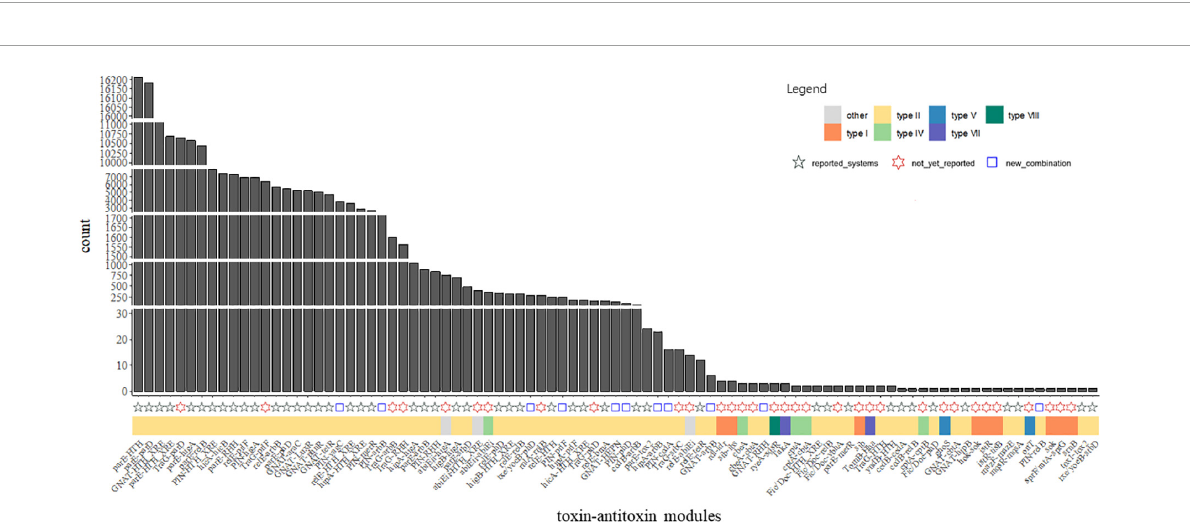
FIGURE4 Abundance of the TA modules among P. aeruginosa population. Count indicates the absolute counts of TA homologs of specific systems, but with inner-strain deduplication. The names at the bottom were the identified TASs, the adjacent tiles were filled in colors which indicate the classification of the closest matched TA. The shapes indicate different labels of all TA systems: modules reported in the previous studies (Fernández-García et al., 2016; Andersen et al., 2017) were represented as black (cid:73) ; modules not yet reported in P. aeruginosa presents as red (cid:65) ; blue square indicates TA modules are new combination of TA with known